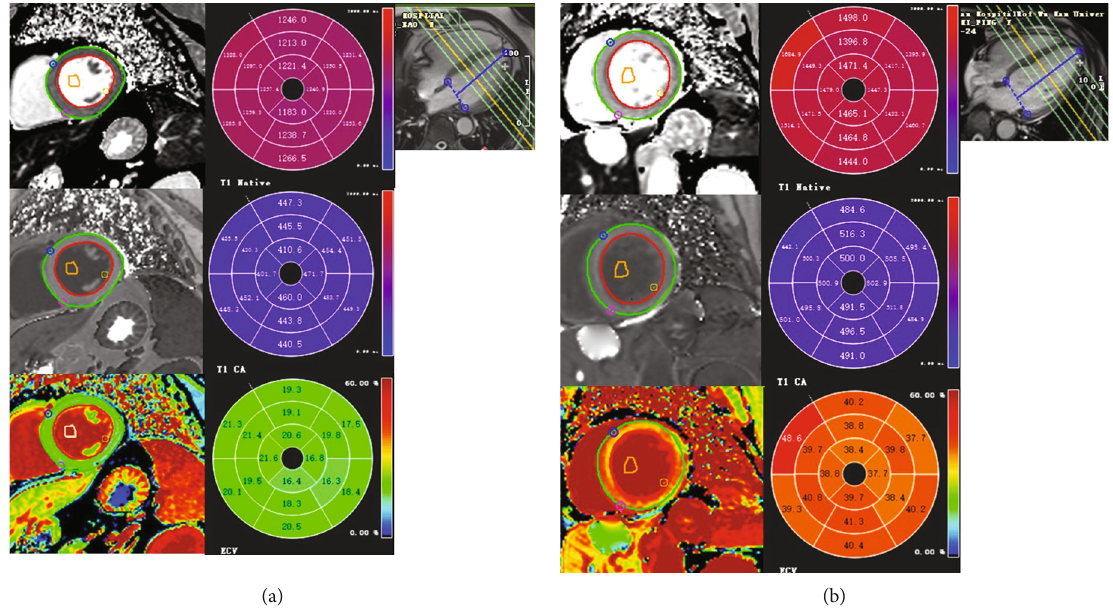
Figure 1: CMR pre- and postcontrast T1 mapping and calculated ECV mapping of representative MM patients (a) without or (b) with